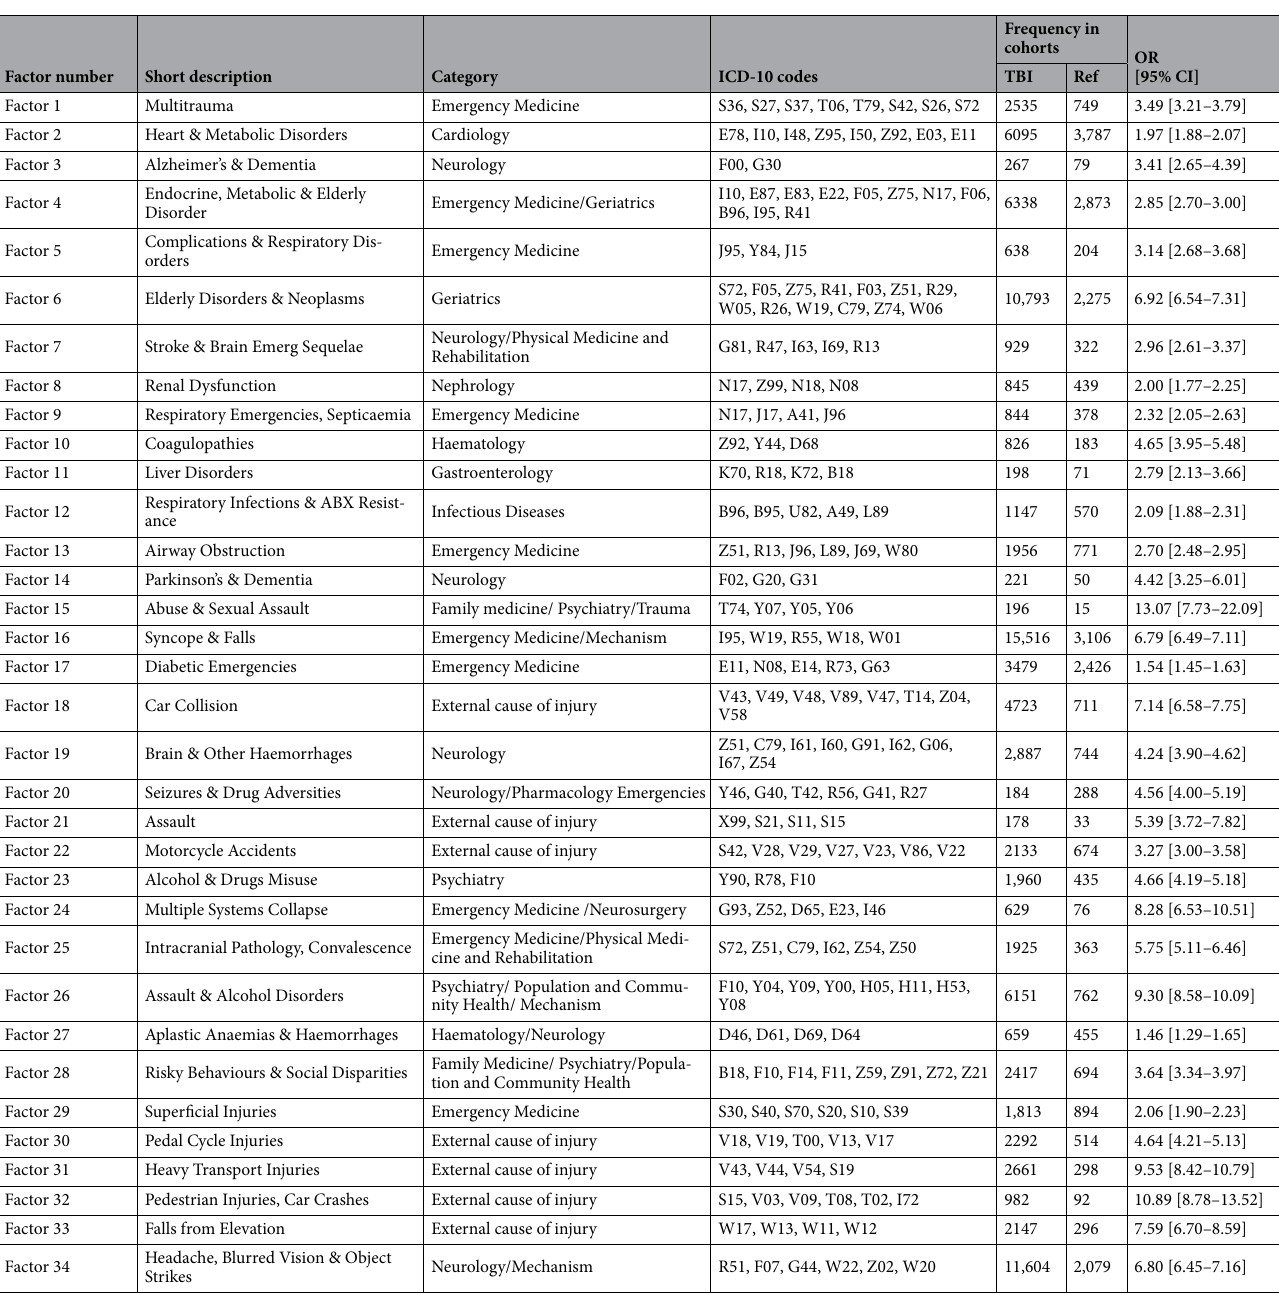
deviation. Frequencies given as